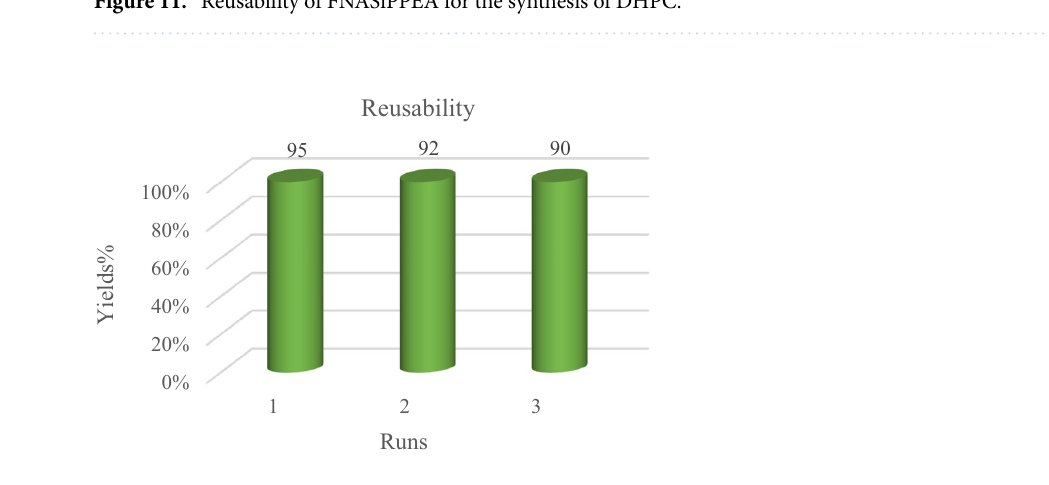
Figure 12. Recyclability of FNASiPPEA for the synthesis of